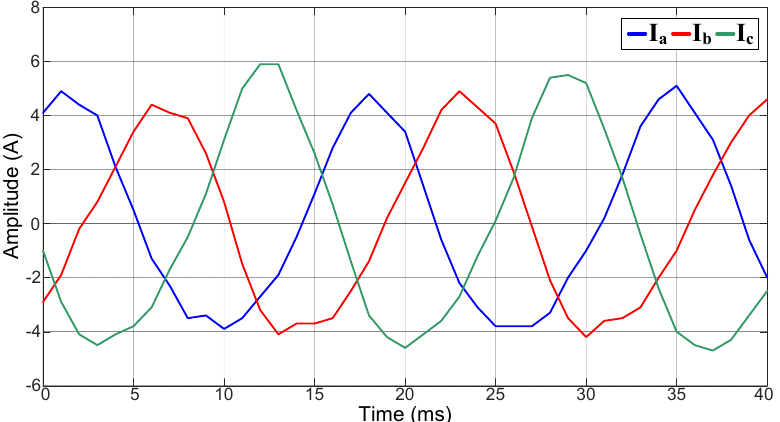
Figure 11. Phase currents from an induction motor with a 12% short-circuit fault condition on phase-C of its stator winding.